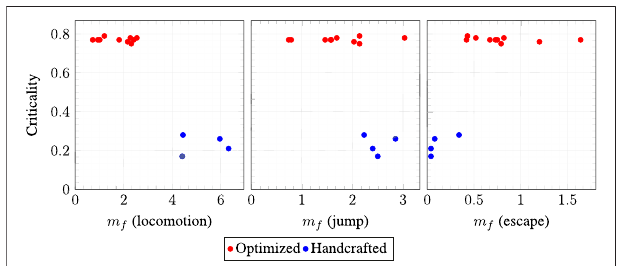
FIGURE 8 | Scatter plots of the criticality vs. the median task achievement degree m f , one point for each morphology, one plot for each